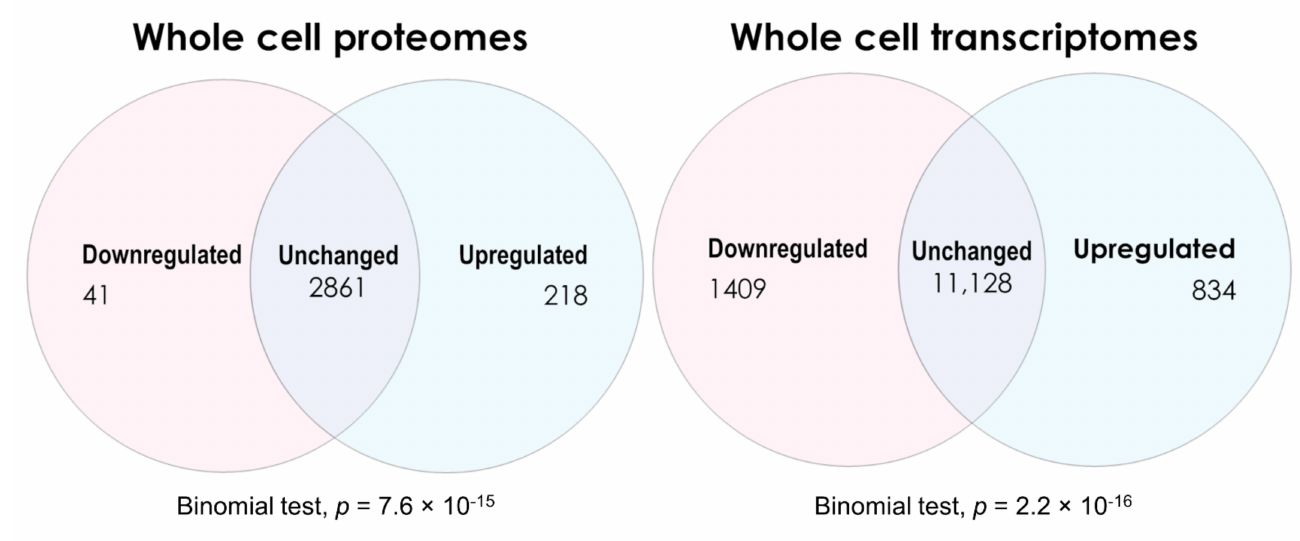
Figure 2. Venn diagrams depicting the numbers of differentially expressed gene products in Myalgic Encephalomyeli- tis/Chronic Fatigue Syndrome lymphoblasts within the whole-cell proteomics and transcriptomics experiments. Two-sided binomial tests were undertaken with H o set to p = 0.5 to assess whether the differentially expressed fractions significantly departed from proportions expected by chance. Resulting significance probabilities ( p ) are